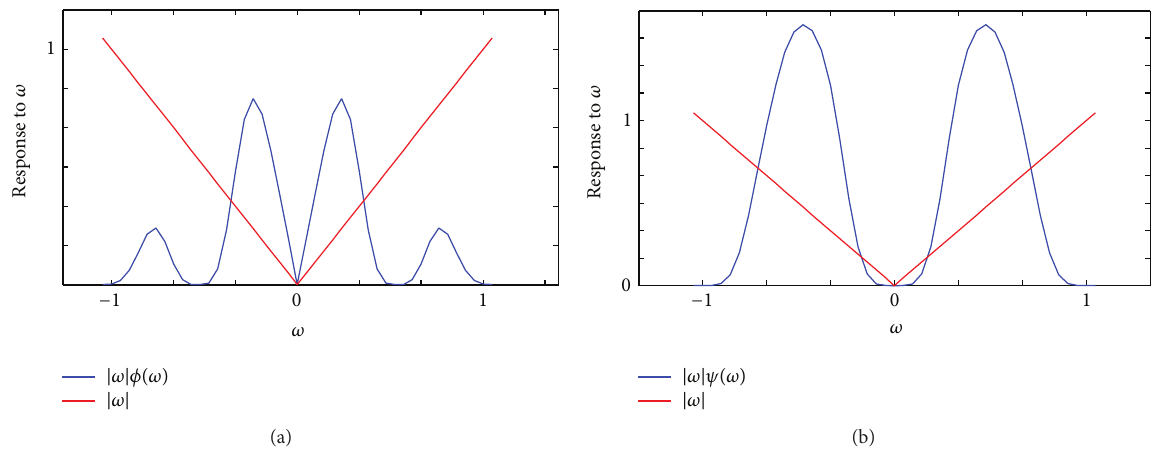
Figure 3: Spectrogram of (a) ramped scaling function and (b) ramped wavelet function. In comparison, the ideal ramp filter was also curved in red